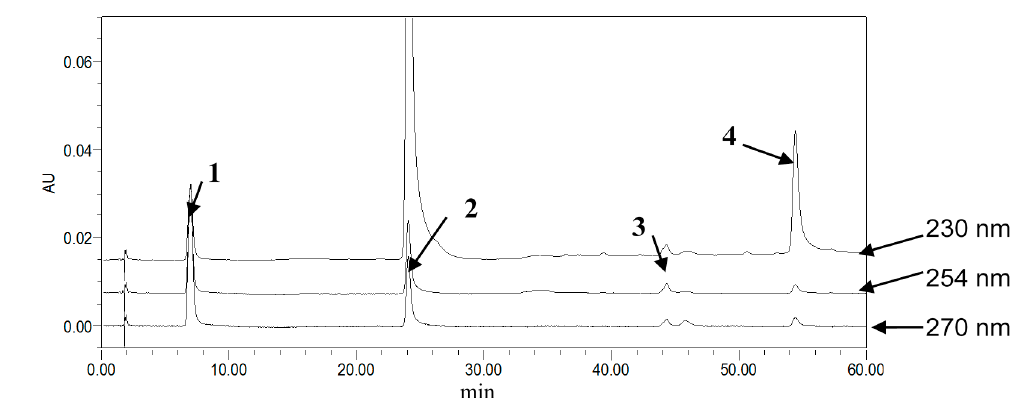
Figure 2. Stacked view of different detector wavelength HPLC chromatograms of mixed reference standards (from topto bottom: 230, 254, 270 nm). Column: SunFire TM C18 (4.6 mm × 150 mm, 5 μ m), temperature of 30 °C.